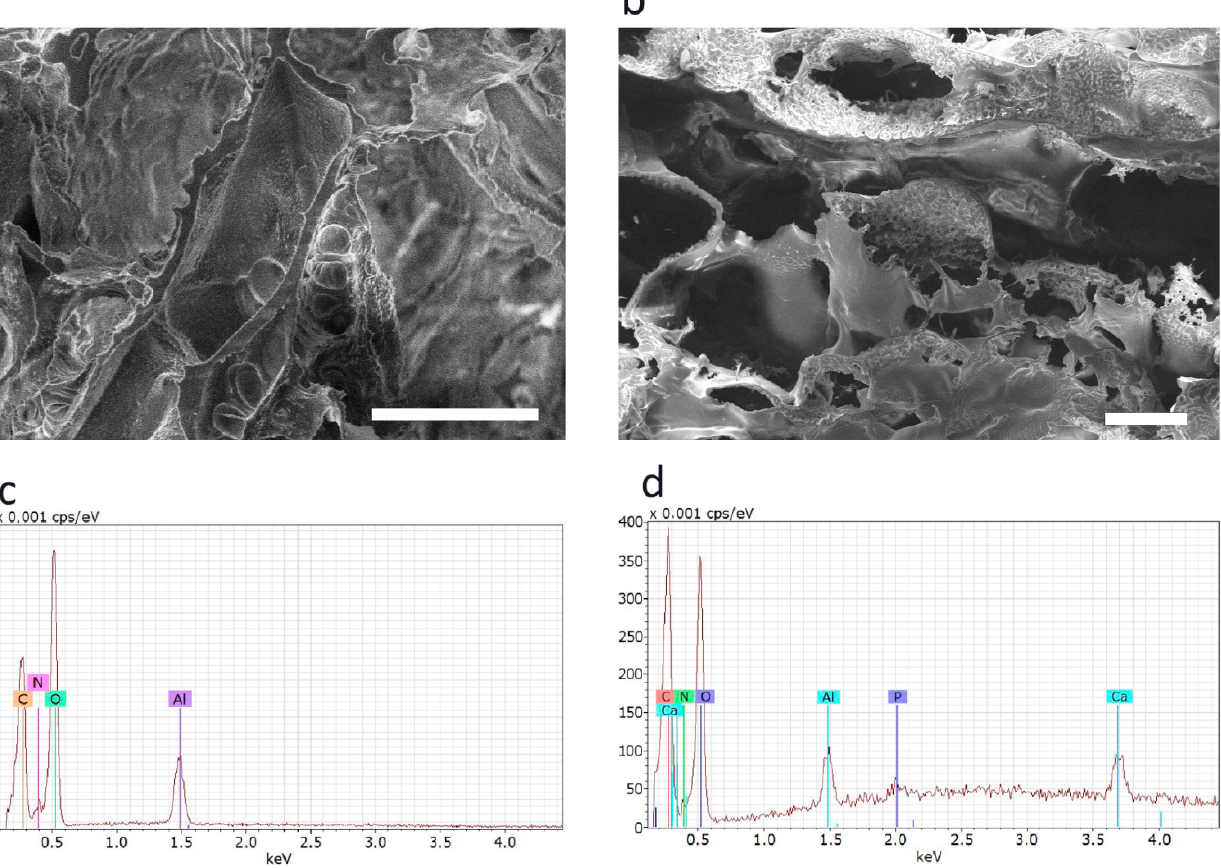
Figure 2. SEM images of the dried Hyal/Ch ( a ) and Hyal/Ch/nHAp-10 ( b ) samples; and EDX spectra of Hyal/Ch ( c ) and Hyal/Ch/nHAp-10 ( d ) samples. Scale bar is 100 μ m.